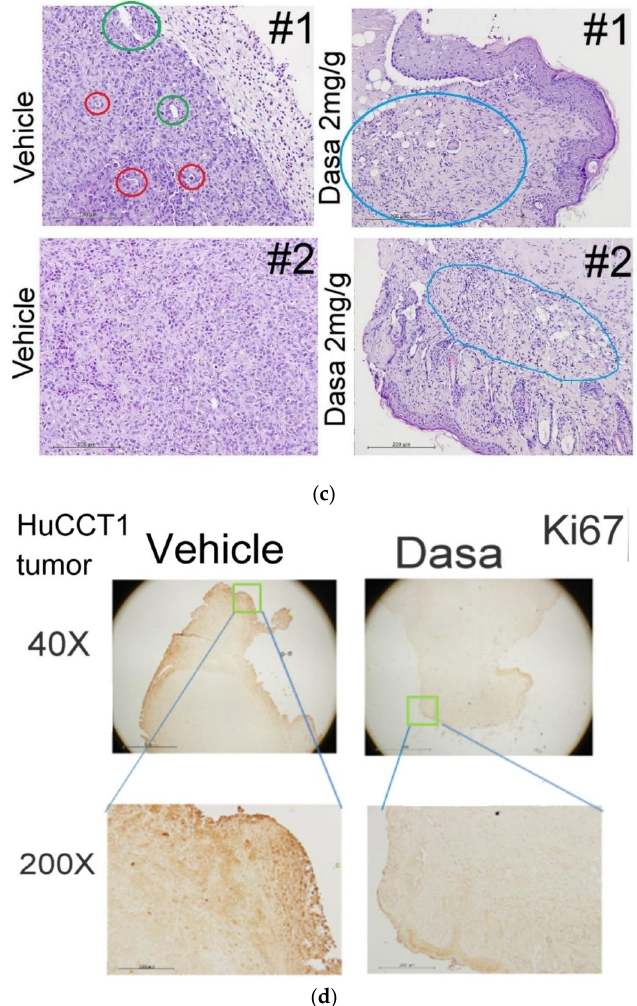
Figure 3. Dasatinib suppressed HuCCT1 tumor development on SCID mice. HuCCT1 cells (4 × 10 6 ) were subcutaneously inoculated on both left and right flanks of three SCID mice for 1 week, followed by applying dasatinib (2 mg/g mouse) ( a , left panel), or dasatinib (0.5 mg/g mouse) ( a , right panel) around the cell inoculation site on one flank twice a week whereas 0.2% DMSO (vehicle) was applied around that on the other flank in the same mouse serving as a control. After drug injection for 1.5 ( a , left panel for 2 mg Dasa/g mouse) and 1.0 ( a , right panel for 0.5 mg Dasa/g mouse) months, the HuCCT1 tumors were collected and pictured ( a ) and then processed for H.E. staining ( c ) and IHC of Ki-60 ( d ). ( b ) is the quantitative data for ( a ), showing the average reduction rate for each Dasa concentration (N = 3 and N = 2 for 2.0 and 0.5 mg Dasa/g mouse, respectively). In ( a , b ), the size of tumors was designated as the volume (cm 3 ) calculated as described in Materials and Methods. In ( c ), the black numbers indicate two different spots (denoted as #1 and #2) on the tissue sections from HuCCT1 tumors with indicated treatments selected for photography. The red and green circles enclose the duct formation and vein, respectively, in the tissues from the vehicle-treated group (left panel) whereas blue circles enclose the granulation tissue, fibrotic tissue and inflammation cells across the tissues from the dasatinib (2 mg/g mouse) group (right panel). In ( d ), the brown staining regions indicate the locations of Ki67. The staining sections were photographed under 40- (upper panel) and 200- (lower panel) fold magnification. The images in the lower panels show the magnified regions selected from marked insets (green rectangles) in the upper panel. The intensity was quantitated by Image J.